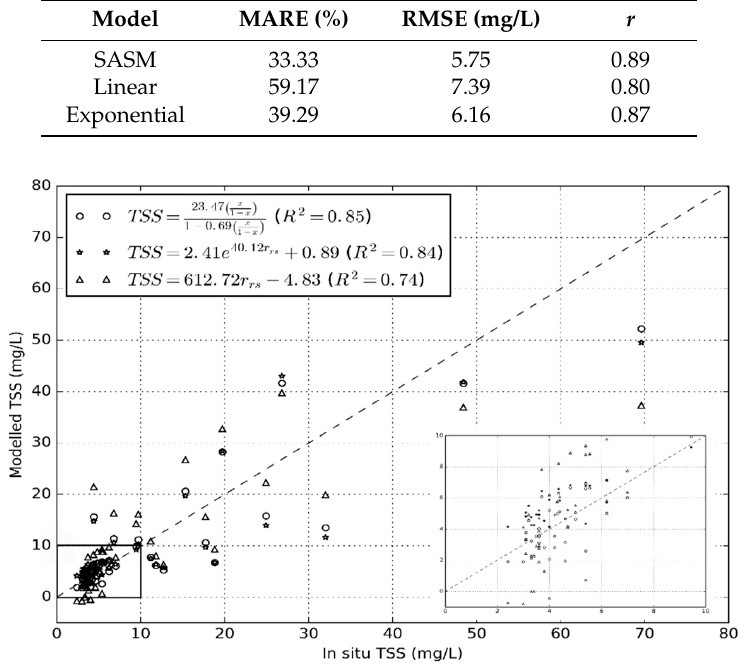
Figure 4. Validation results using the LOOCV method for the three models. The box at the bottom right is a blow out of the TSS < 10 mg/L and the dashed line is 1:1 line.